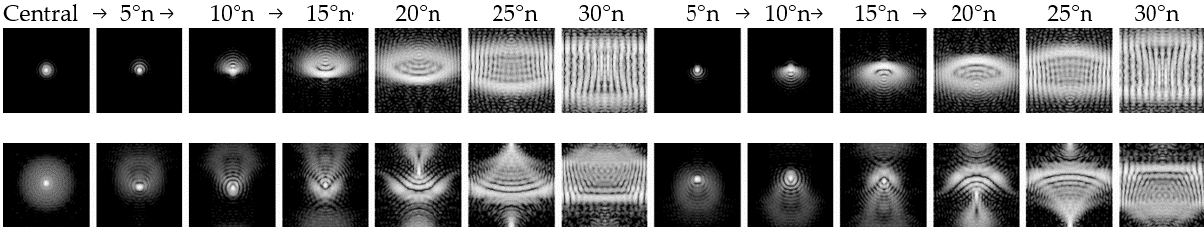
Figure 9. Simulated retinal image quality from the central up to 30° nasal and temporal. ( Top row ): Proclear monofocal.